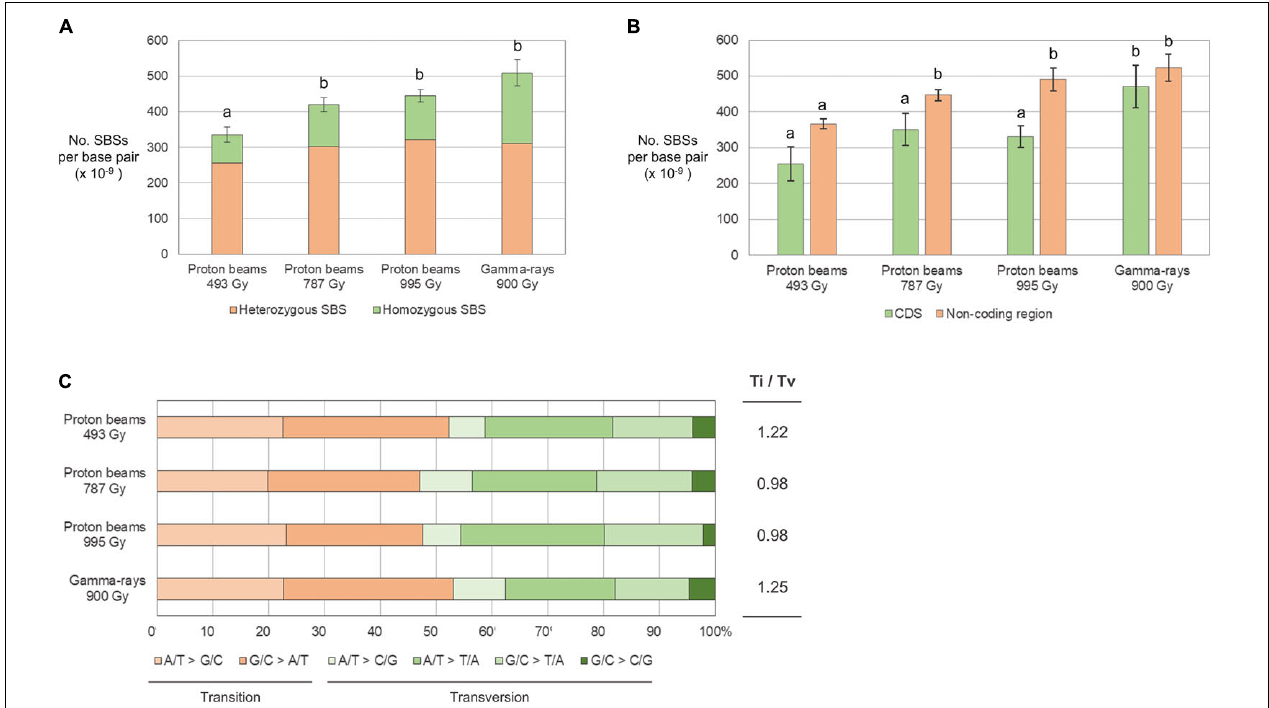
FIGURE 5 | Frequency and types of single base substitutions (SBSs) in M 2 lines derived from proton beam and gamma-ray irradiation. (A) Frequency of SBSs classified according to zygosity. (B) Frequency of SBSs classified according to their location on protein coding (CDS) and non-coding DNA regions. (C) Proportions of SBSs classified according to the types of changed nucleotides. Different letters above the bars indicate statistical differences determined by one-way ANOVA followed by Duncan’s multiple range test for classification criteria among the irradiation groups. Ti/Tv is the ratio between frequency of transitions and